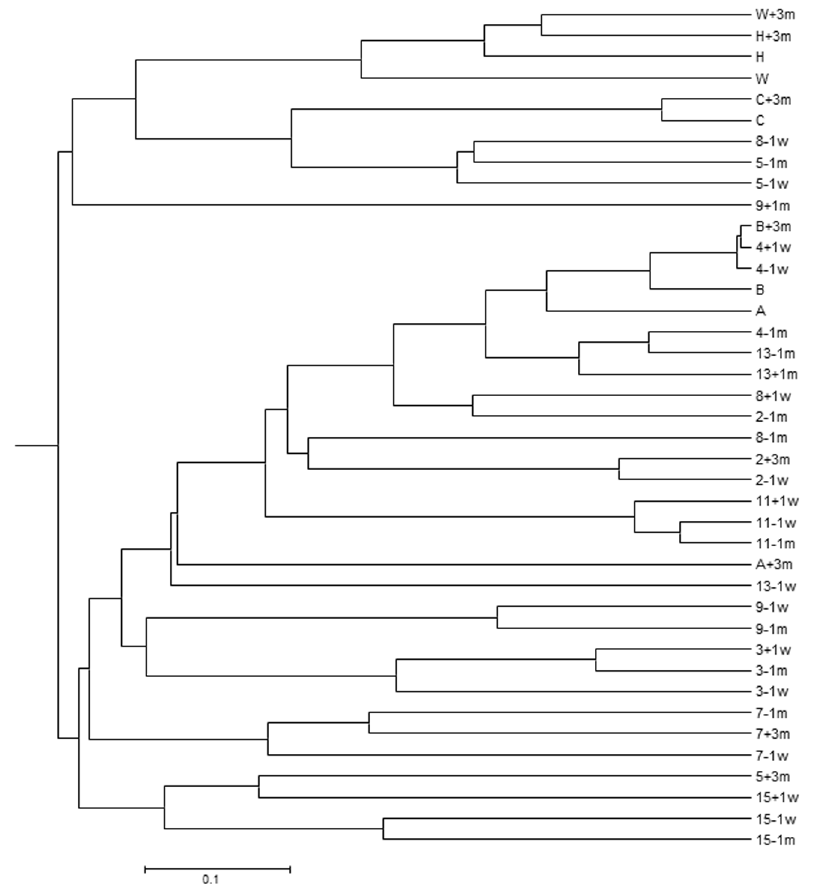
Figure 3. Comparison of the relative abundance of fecal microbial communities of each sample using the Yue and Clayton theta measure of dissimilarity. Dissimilarity between the relative abundance of communities was calculated with the Yue and Clayton measure of dissimilarity within Mothur and clustering performed using the UPGMA algorithm. The first numeral/letter indicates the patient or control, the last numeral indicates when the sample was obtained. Refer to Figure 1 legend for sample labelling.